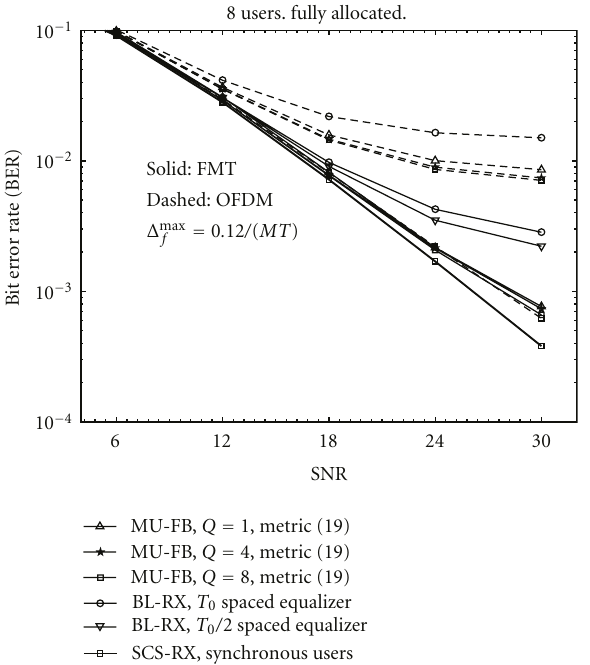
Figure 7: BER as a function of SNR. 8 interleaved users fully allocated. FMT with M = 32 and N = 40 . OFDM with M = 32 and CP = 8